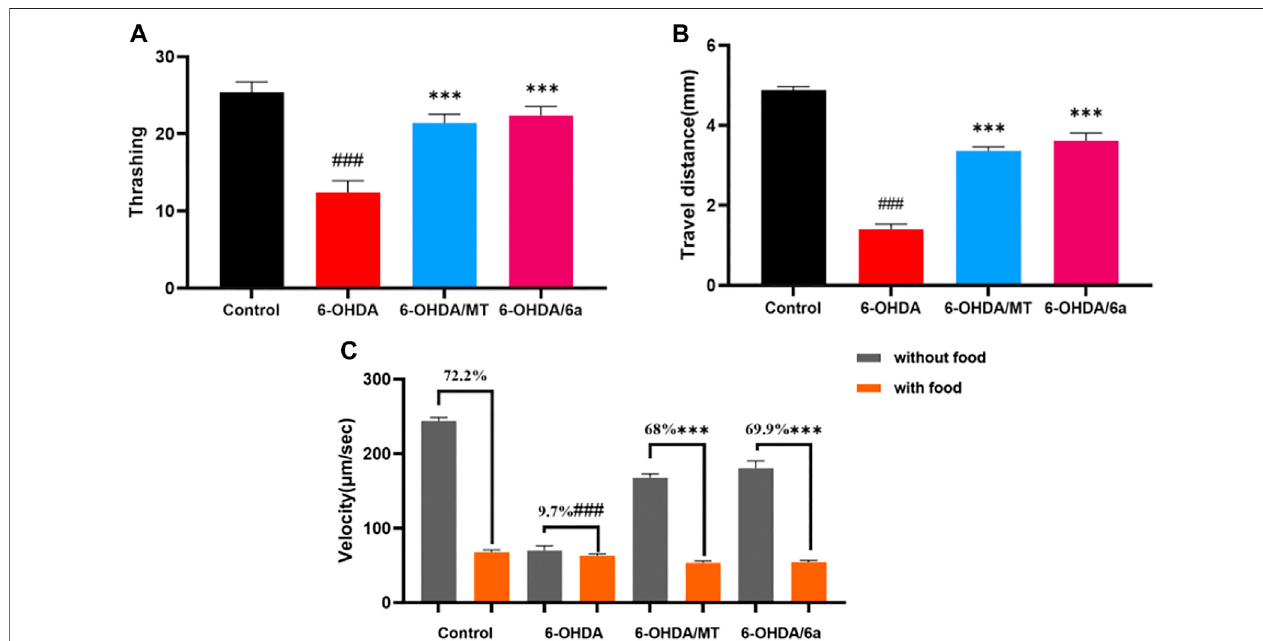
FIGURE7| EffectofMTand6aonDAneuronalfunction. (A) ThrashingbehaviorofN2. (B) TraveldistancesofN2. (C) VelocityofN2inNGMplateswithandwithout food and basal slowing response. (### p < 0.001, compared with the control; *** p < 0.001, compared with the 6-OHDA-treated group).